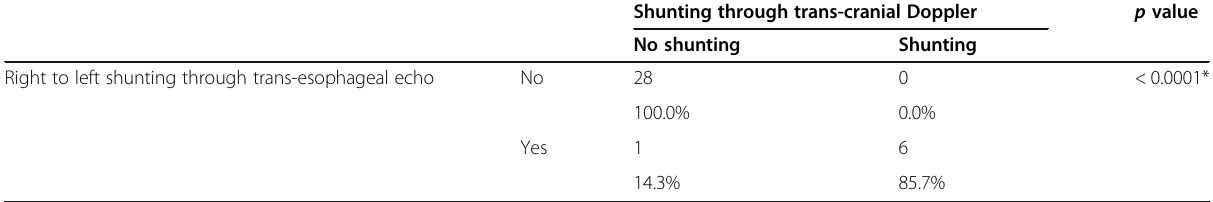
Shunting through trans-cranial Doppler p value No shunting